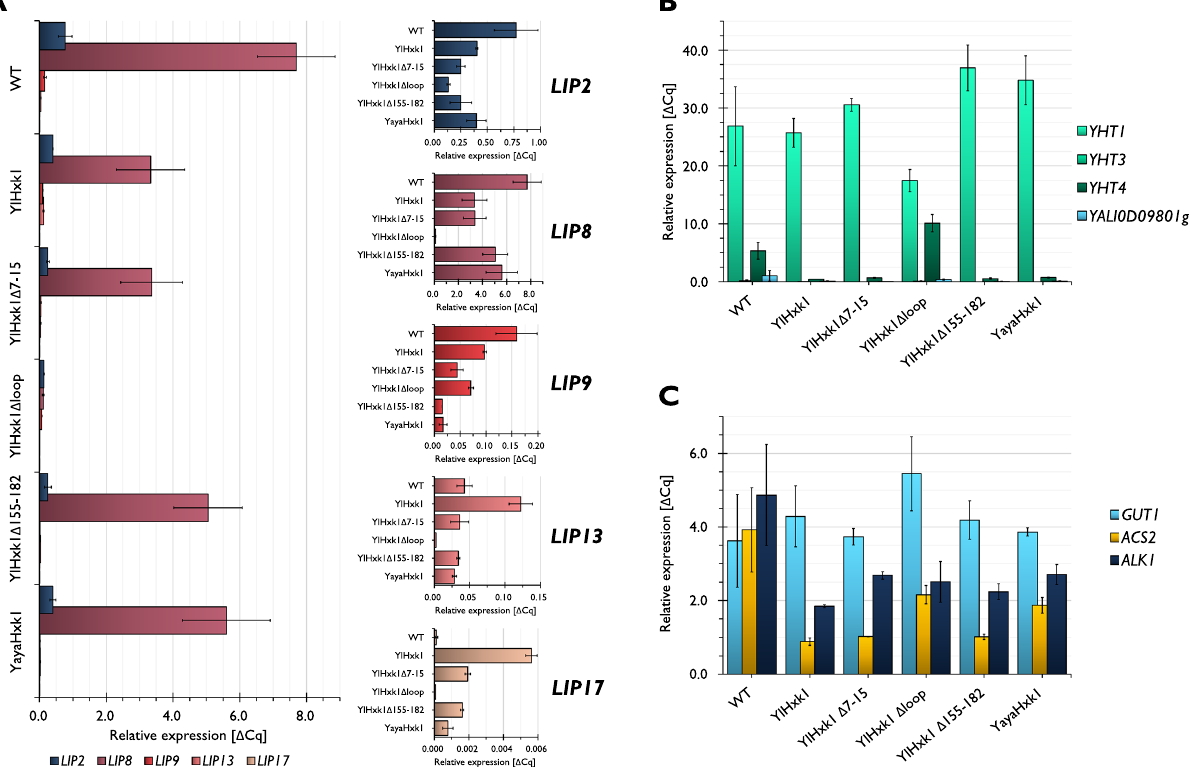
Figure 7. Impact of hexokinase on gene expression levels in Y. lipolytica. ( A ) Transcript levels of lipase- encoding genes; ( B ) expression of hexose transporters and N -acetylglucosamine transporter ( YALI0D09801g ); ( C ) expression of the genes involved in utilization of glycerol ( GUT1 ), acetate ( ACS2 ) and n -alkanes ( ALK1